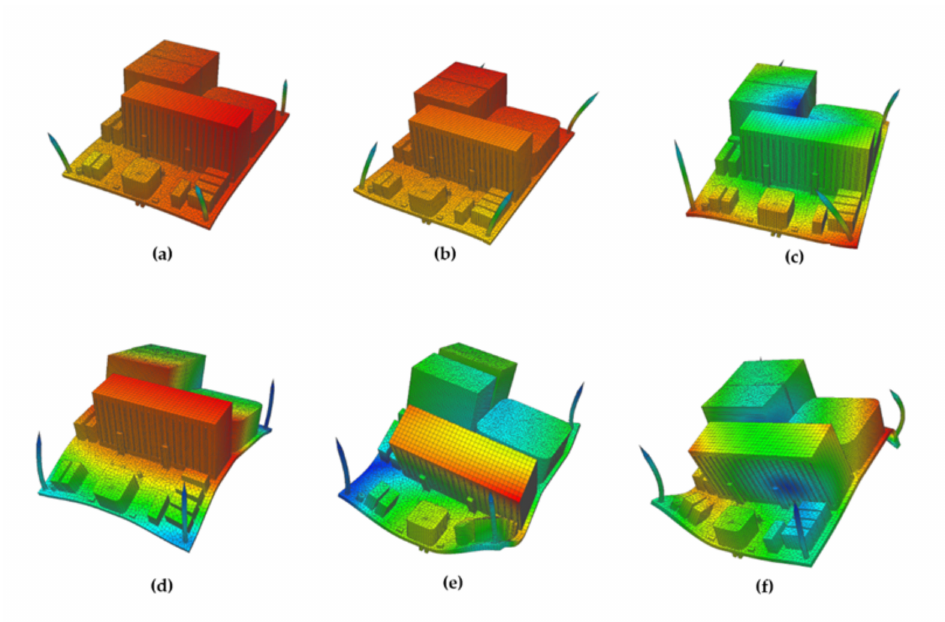
Figure 9. Effects of a natural frequency on the PCB ( a ) 21.97 Hz. ( b ) 23.67 Hz. ( c ) 47.12 Hz. ( d ) 74.63 Hz. ( e ) 212.75 Hz. ( f ) 222.69